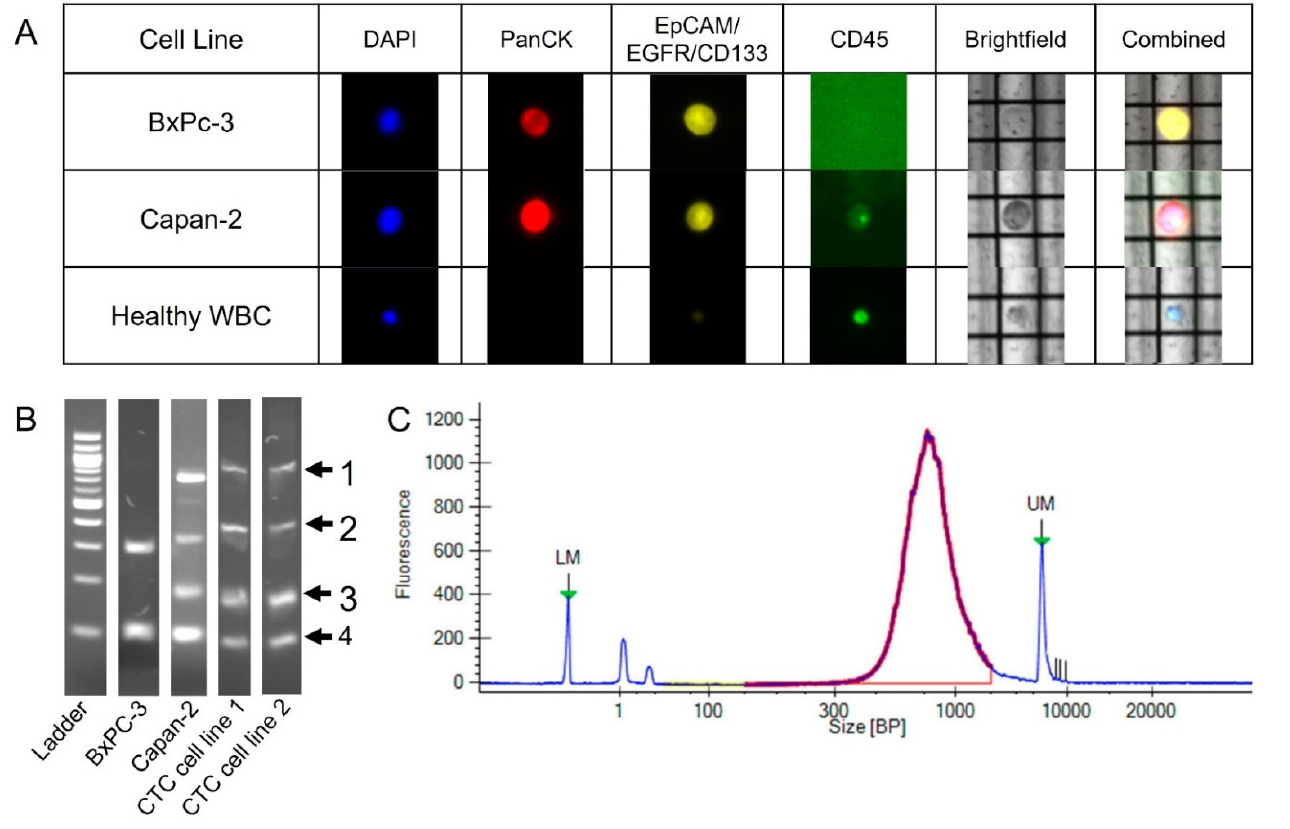
Figure 2. Examples of cell line cell results from the DEPArray, WGA QC, and library preparation QC. ( A ) Representative images of cells on the DEPArray. Cells were stained with PanCytokeratin, EpCAM/CD133/EGFR cocktail, CD45 and DAPI for identification and selection. ( B ) WGA QC results. Markers 1, 2, 3 and 4 indicate regions on the gel where bands should appear. Each region represents a different portion of the genome. ( C ) An example of post library preparation QC results. LM and UM correspond to lower and upper markers, respectively. The sample size is distributed in the expected size range of 100–2000 bp in purple/red. Blue lines indicate reading in the regions not expected to have sample.